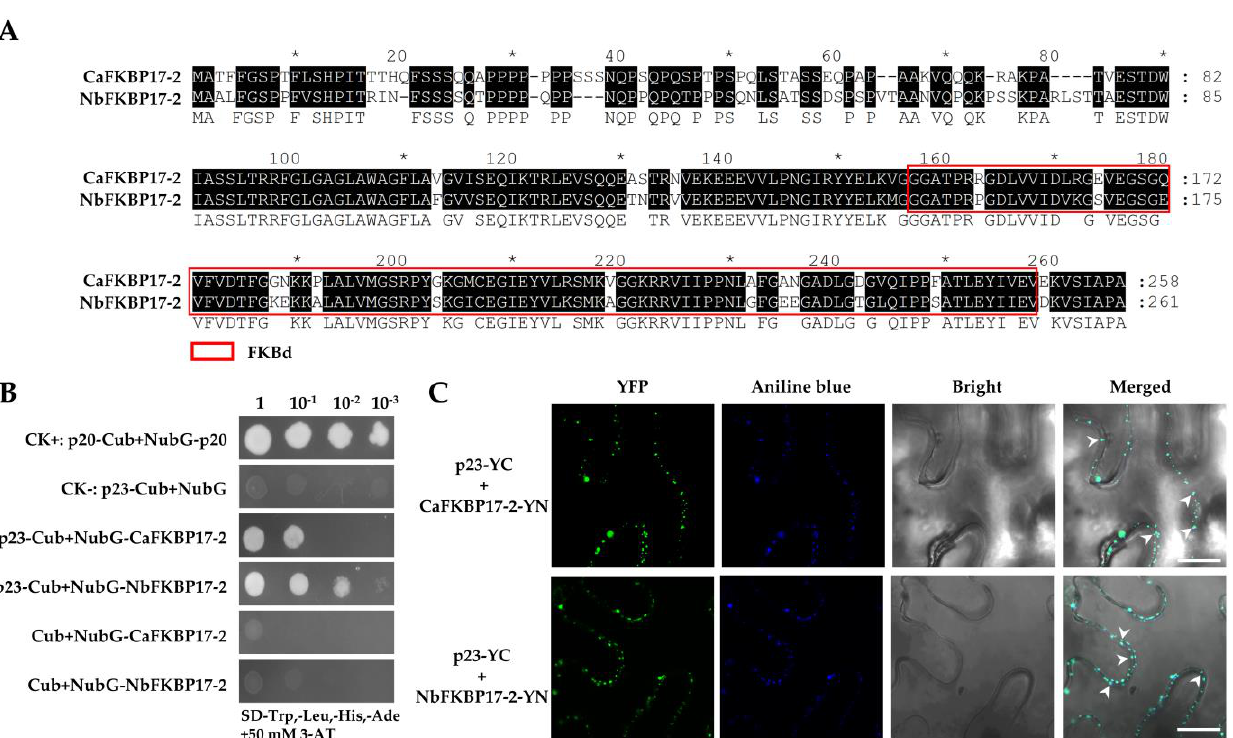
Figure 1. Interactions between citrus tristeza virus (CTV) p23 and FKBP17-2. ( A ) Alignment of deduced amino acid sequences of CaFKBP17-2 and NbFKBP17-2. Shaded letters indicate the conserved amino acid residues. The FK506 binding domain (FKBd) was indicated by a red box. ( B ) Split-ubiquitin yeast two-hybrid assays. p23 was fused to the C-terminal half of ubiquitin (Cub). CaFKBP17-2 and NbFKBP17-2 were respectively fused to the N-terminal half of ubiquitin (NubG). The yeast cell of co-transformed with p20-Cub and NubG-p20 was used as a positive control, and the yeast cell with p23-Cub and NubG was used as a negative control, respectively. A series of dilutions (1, 10 − 1 , 10 − 2 , and 10 − 3 ) were shown at the top of the figure. ( C ) Bimolecular-fluorescence complementation assays. The p23 fused to YFP C-terminal (p23-YC) was separately co-expressed with CaFKBP17-2 and NbFKBP17-2 fused to YFP N-terminal (CaFKBP17-2-YN and NbFKBP17-2-YN) by agroinfiltration on N. benthamiana leaves. Aniline blue stained callose at plasmodesmata (PD) was used as a marker. Arrow heads pointed to PD. Confocal images were taken at 48 hpi. Bars, 20 µ